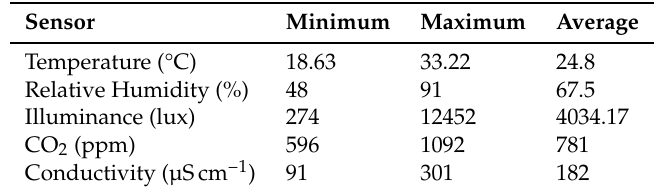
Table 5. One-month (August) sensor data for tomato crop at PCH,